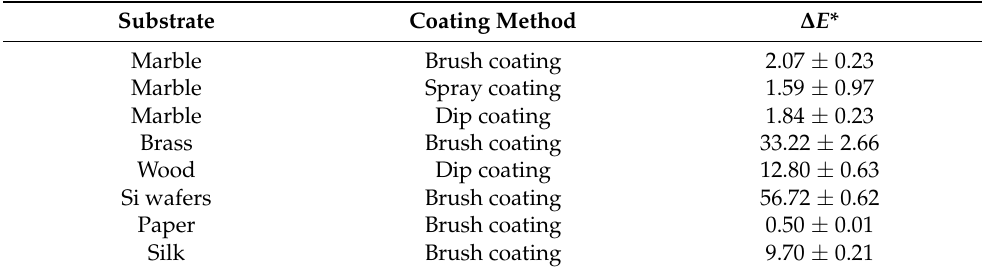
Table 2. Color changes ( ∆ E *) calculated using Equation (1).